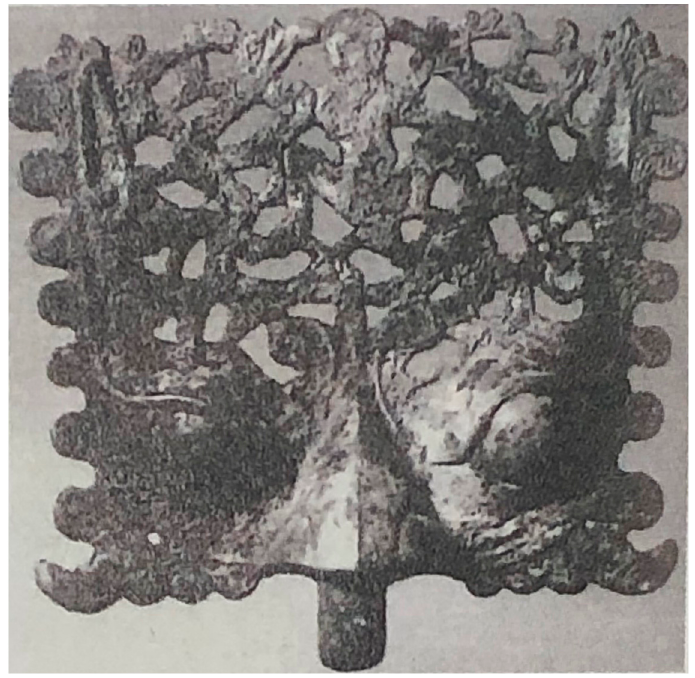
Figure 15. Pushou with dissolved human-animal juxtaposition motif, gilt bronze, excavated from Datong, Shanxi Province; after (Datongshi bowuguan 1983, plate 4.3).